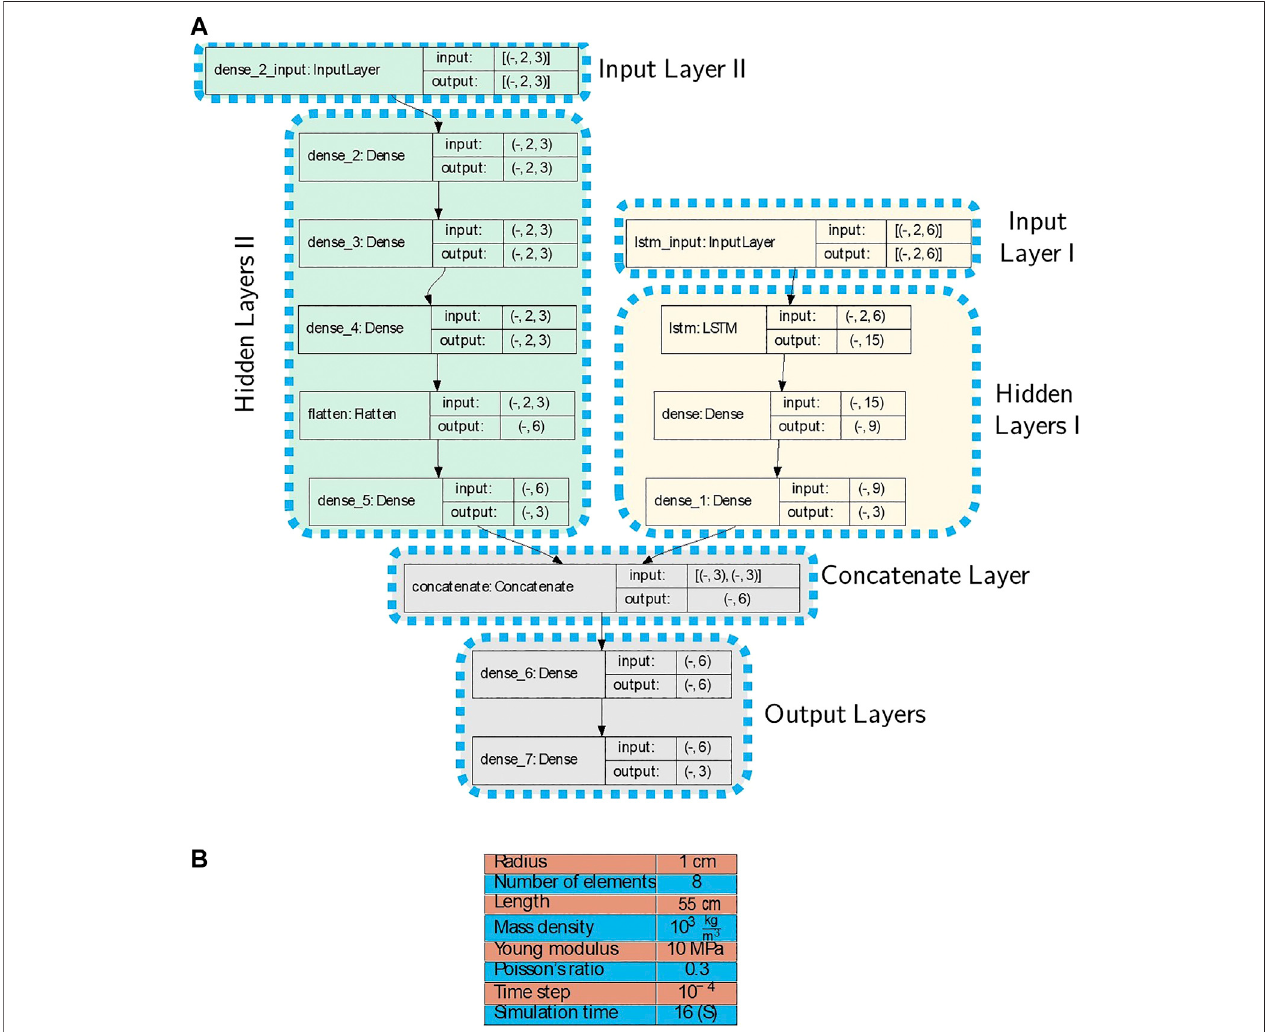
FIGURE 4 | (A) : The model architecture used for the second simulation example. There are two Input layers, the fi rst one is the poses of the node and the second input is the applied forces on the node. The fi rst dimension of inputs and outputs in each layer are unspeci fi ed and can vary with the size of batches. (B) : Rod properties and simulation parameters used in the second